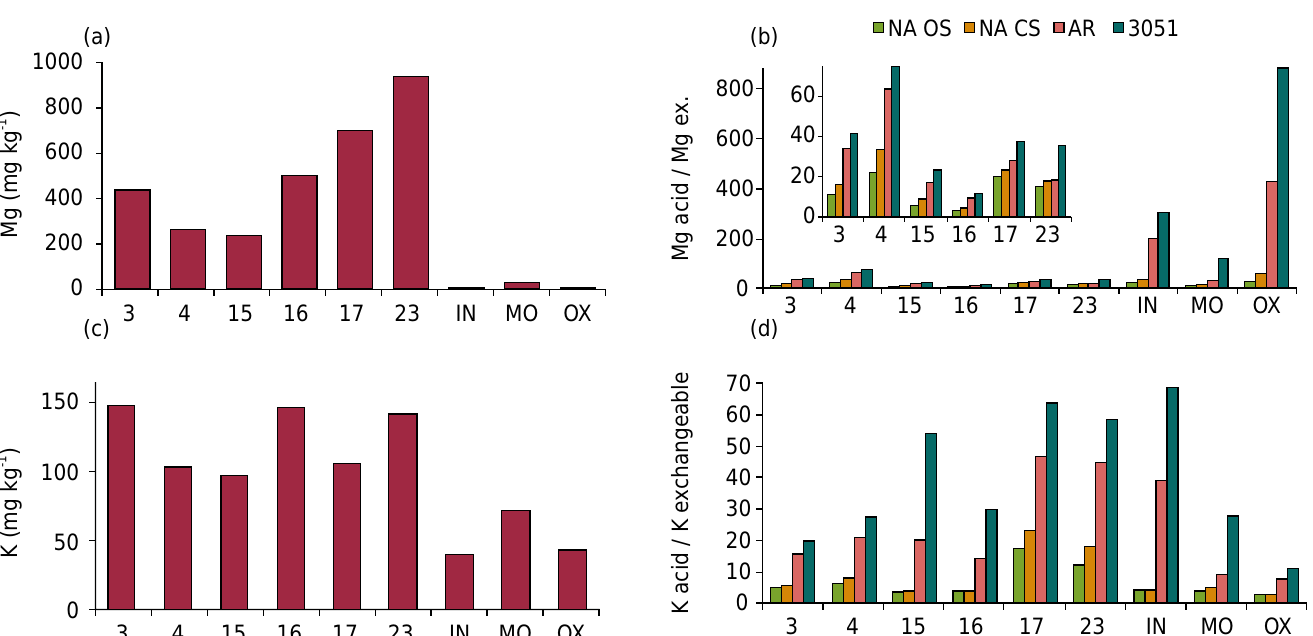
Figure 2. Exchangeable Mg and K of the clay fraction (a, c) and ratios between contents extracted by acid solutions (nitric acid in open system (NA OS), nitric acid in a closed system (NA CS), aqua regia (AR ), and EPA 3051A (3051)) and exchangeable (ex.) Mg and K (b, d). IN: Inceptisol; OX: Oxisol; MO: